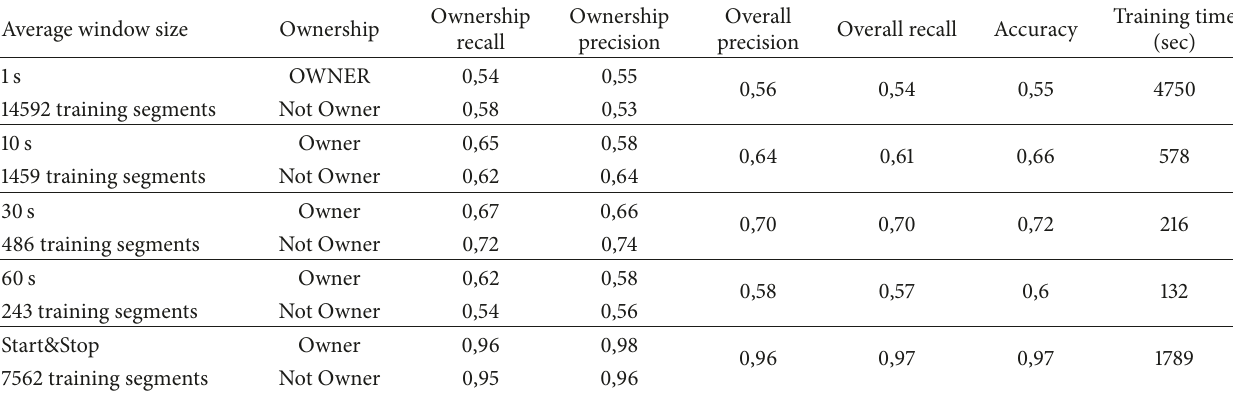
Table 10: 𝐸 31 , precision, recall, accuracy, and training time evaluated by using MLP for different windows sizes. Average window size